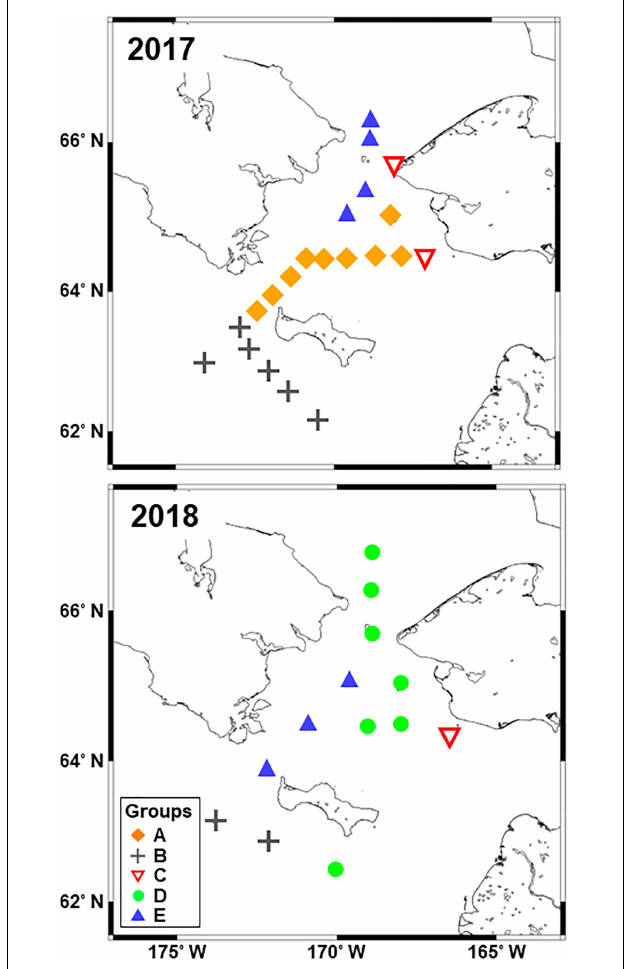
FIGURE 5 | Horizontal distribution of the five groups identified from the Bray–Curtis similarity analysis based on zooplankton abundance (cf. Figure 4 ) in the northern Bering Sea during July of 2017 and